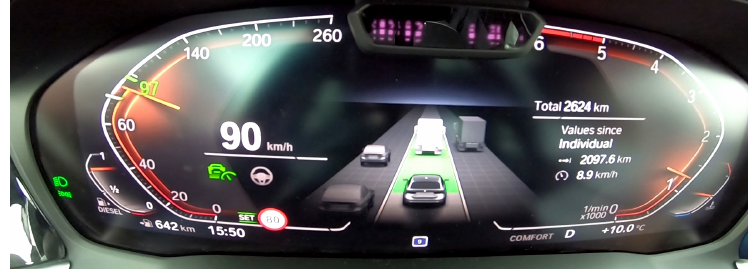
Figure 3. Example BMW HMI design.